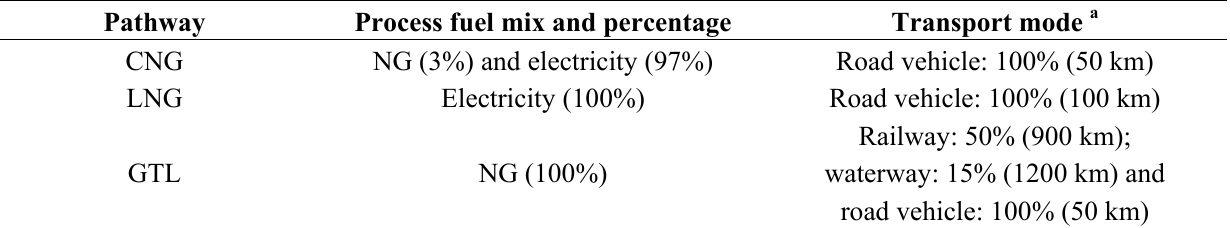
Table 4. Data of process fuel and transport mode for NG-based fuel.